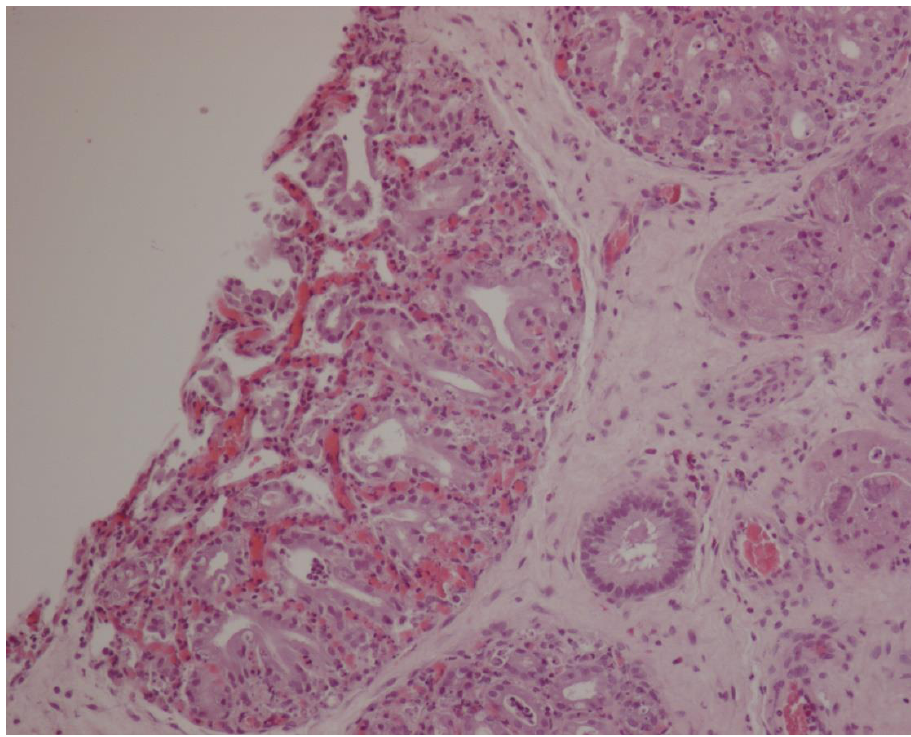
Figure 5. Histologic sampling at day 1 postpartum. In the middle of the figure, a microcaruncle is visible (HE-10× magnification).